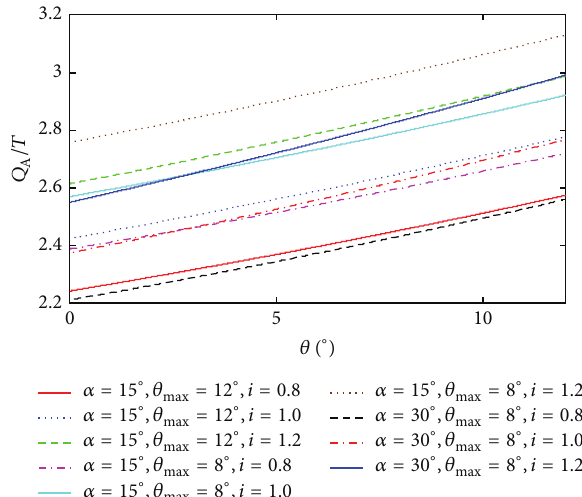
Figure 12: Relationship between 𝑄